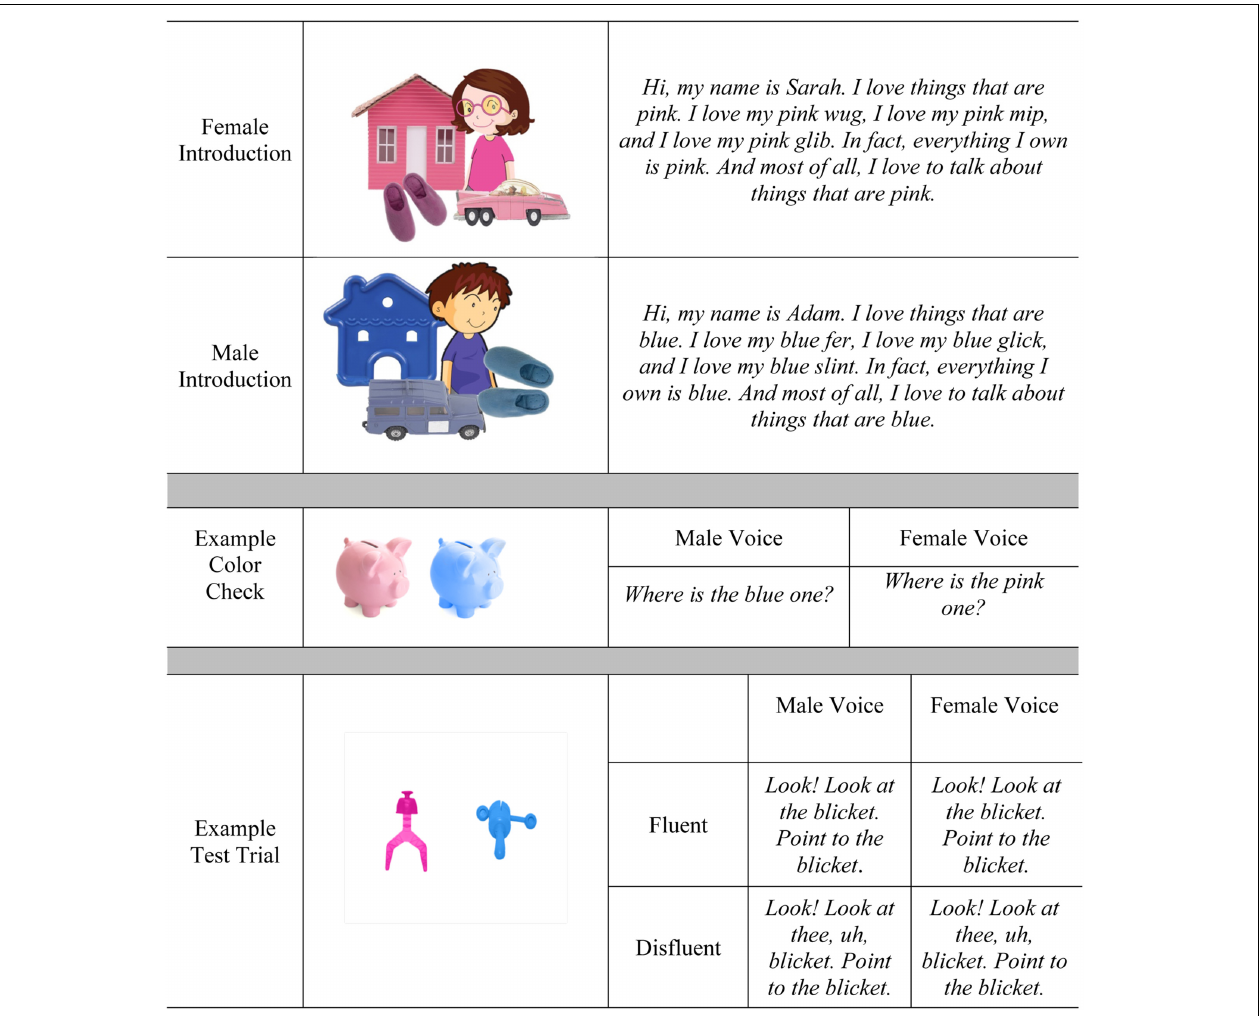
FIGURE 1 | Testing sequence with examples of visual and auditory materials. Images are adapted from “Clipart.com” (http://www.clipart.com). Copyright 2018 by Vital Imagery Ltd. Reprinted with